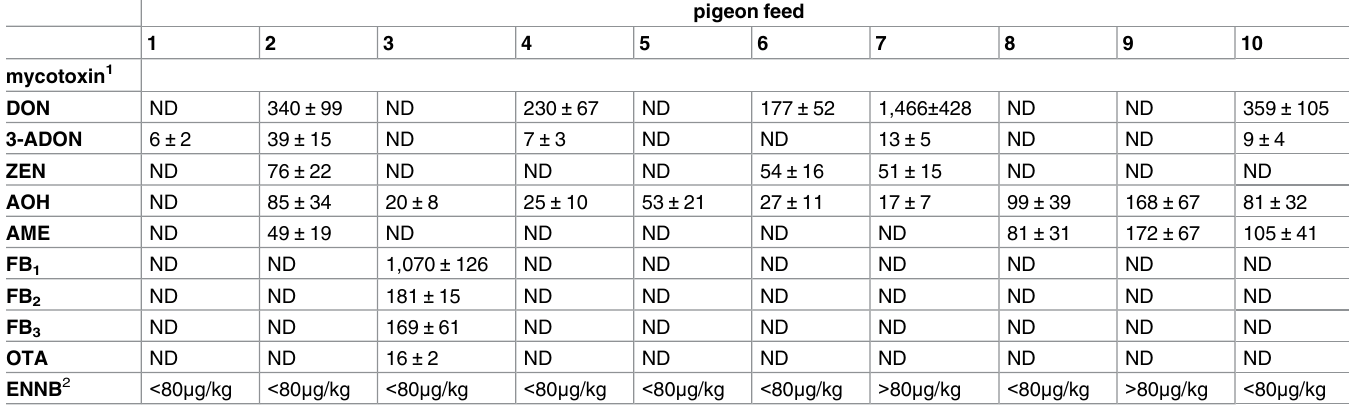
Table 1. Occurrenceof mycotoxins ( μ g/kg) in ten commerciallyavailable racing pigeon feed samples.